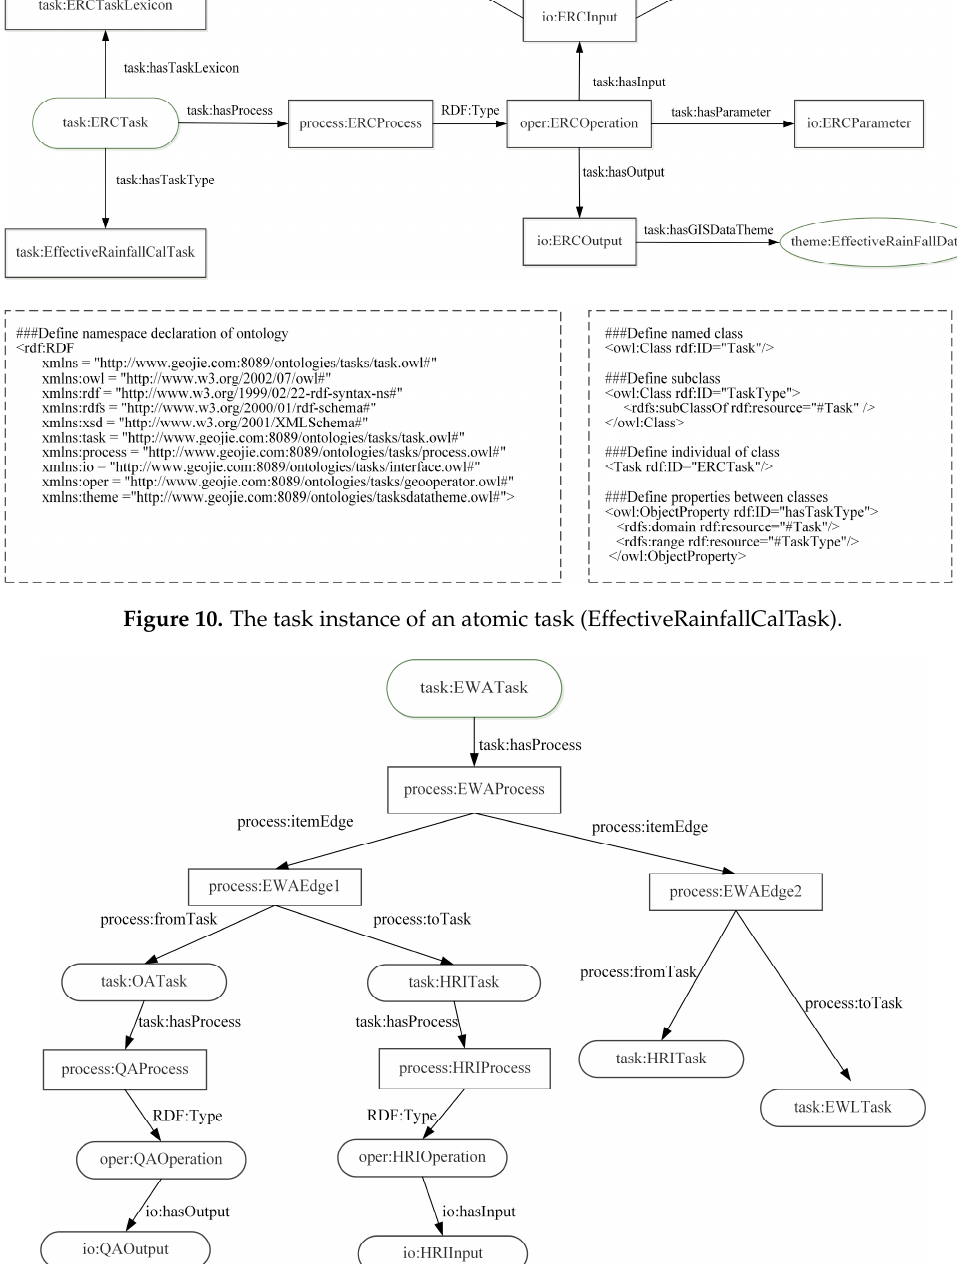
Figure 11. The task instance of a composite task (EarlyWarningAnalysisTask).